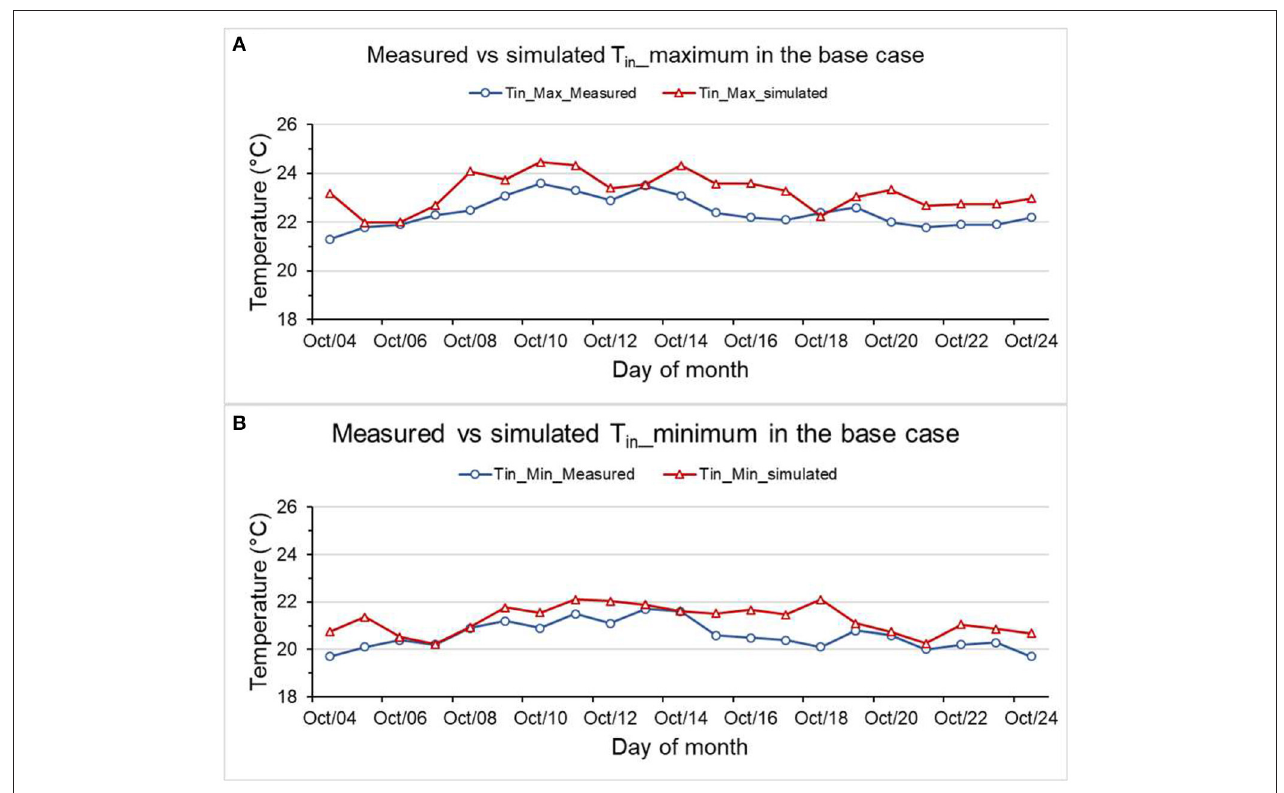
FIGURE 8 | Comparison between measured vs. simulated (A) T in maximum of Case 1a, and (B) T in minimum of Case